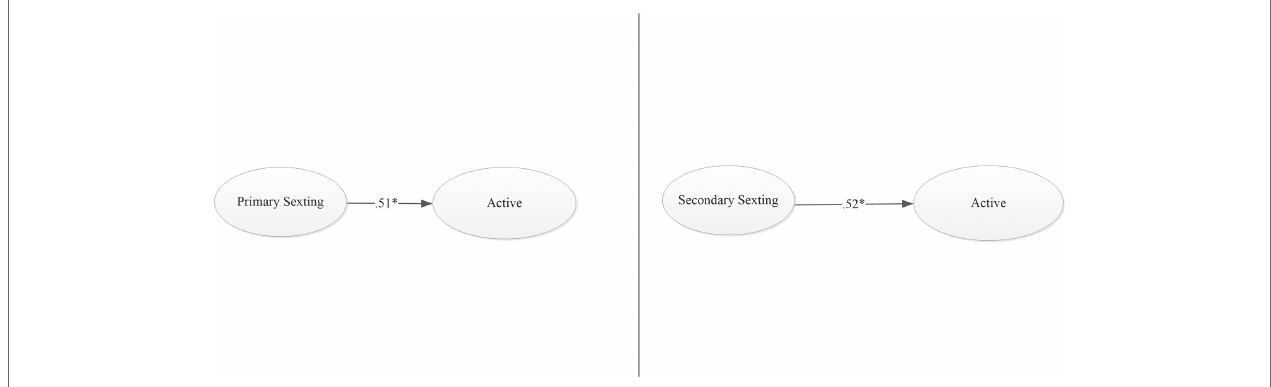
FIGURE 1 | Graphic solution of the sexting models to active